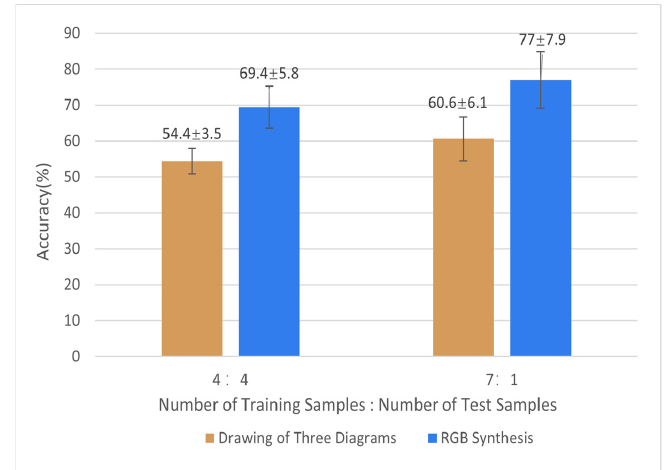
Figure 7. Prediction accuracy of three-map plotting and RGB synthesis under different sample ratios. (Assuming that each group contains a healthy sample and a depression sample, 4:4 means that four groups are the training set and the other four groups are the test set; 7:1 means that the seven groups are the training set and the other one group is the test set. Additionally, the healthy and depressed samples in all groups were from different participants).